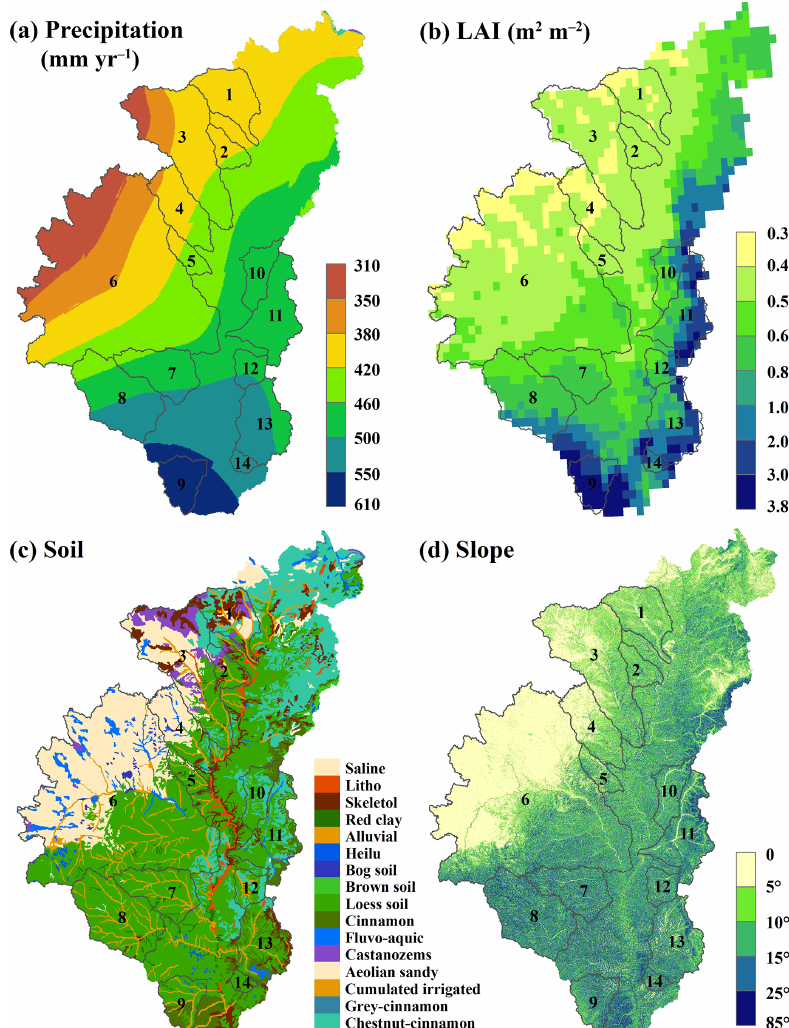
Figure 2. Spatial distribution of (a) annual precipitation (1961–2011), (b) growing season leaf area index (LAI, 1982–2011), (c) soil type, and (d) slope in the study